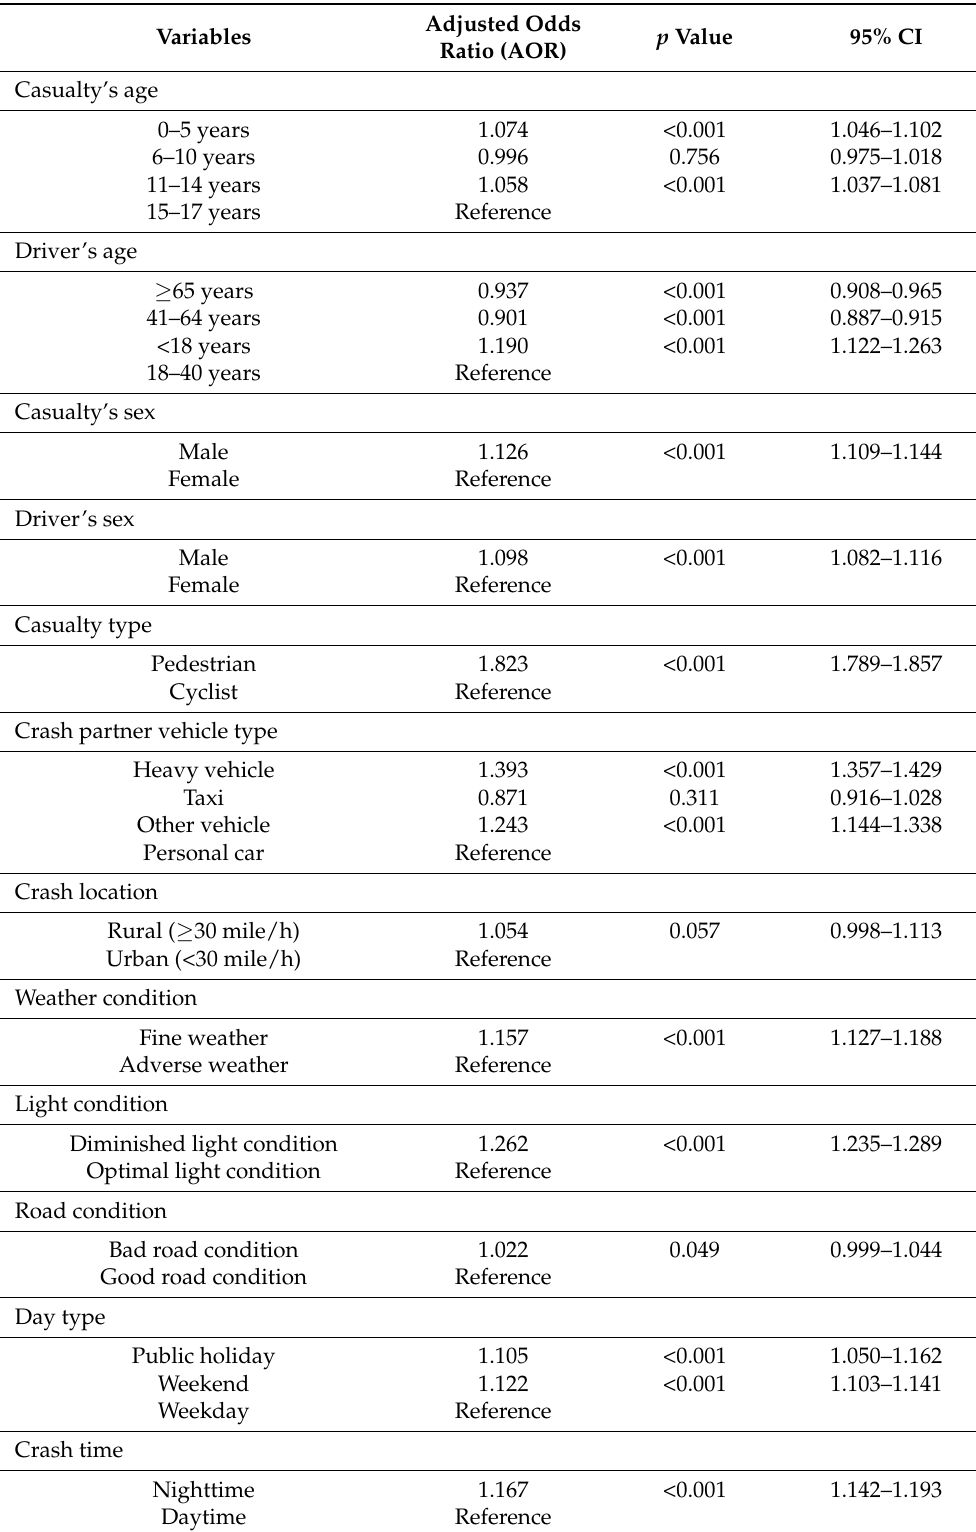
Table 2. Multivariate analysis using multiple logistic